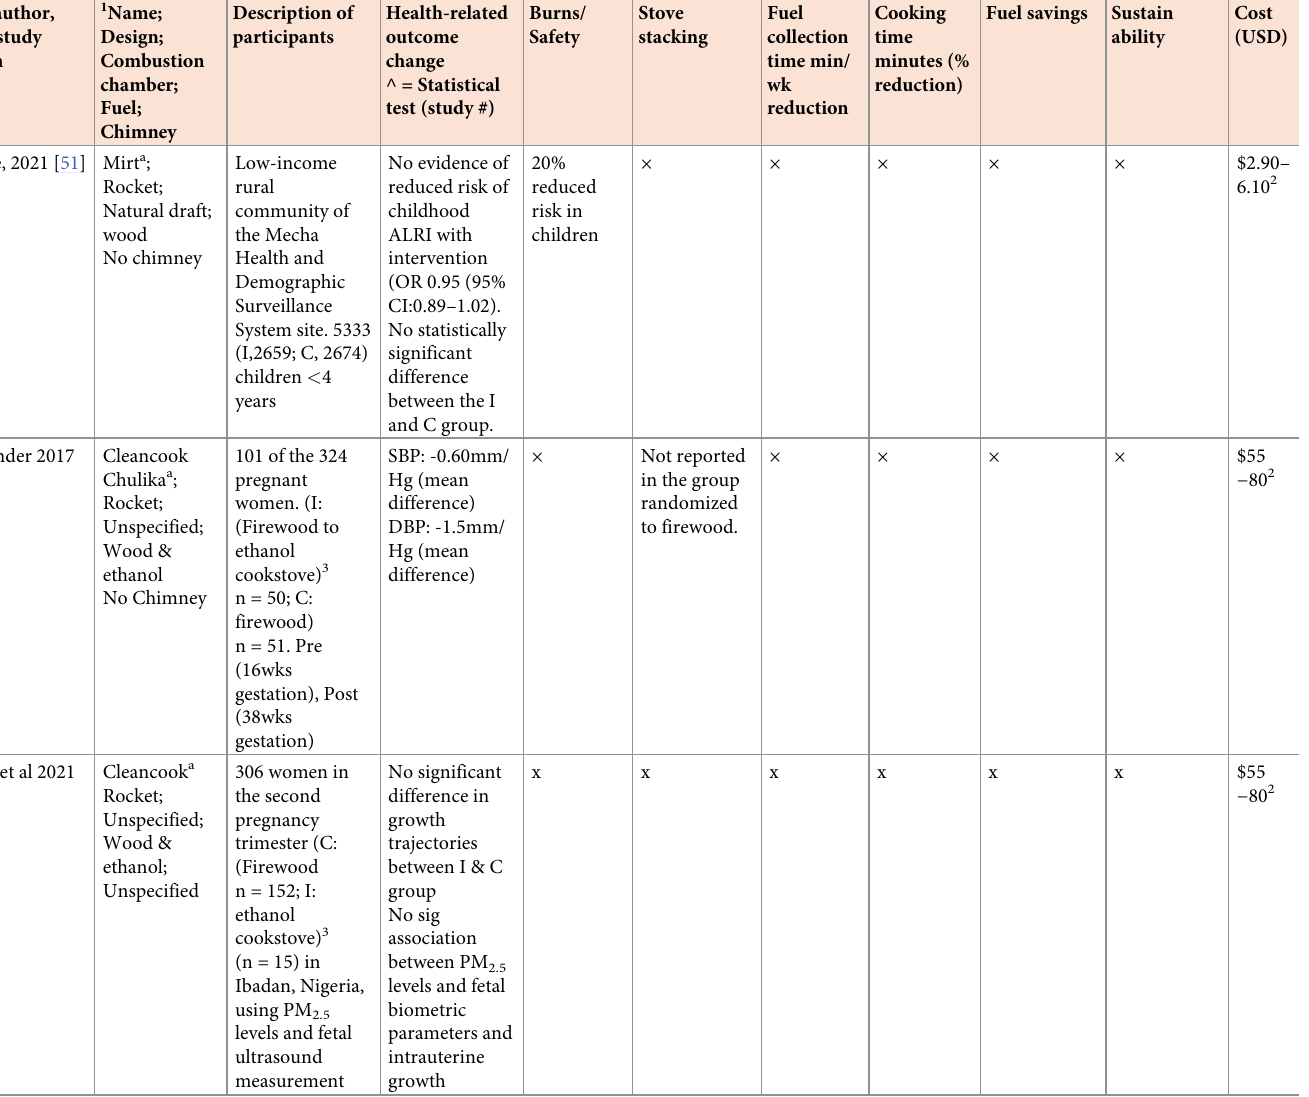
Table 5. Description of health outcomes by author, ICS design and